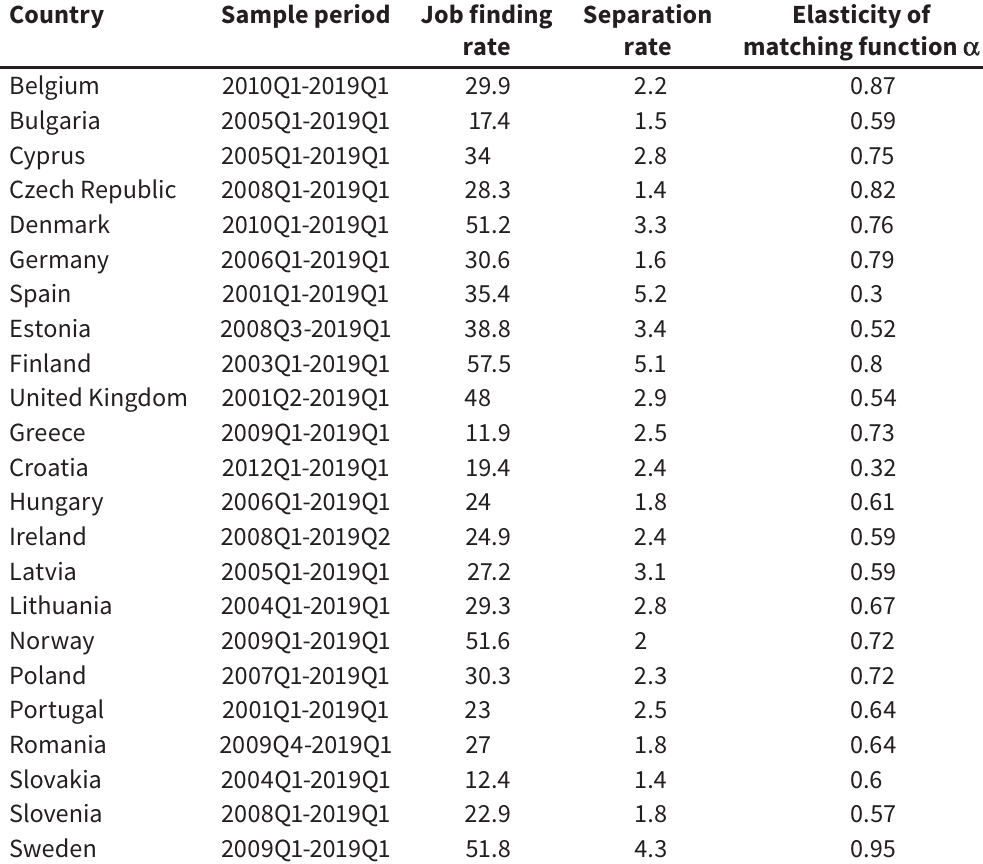
Worker flow rates and matching elasticities